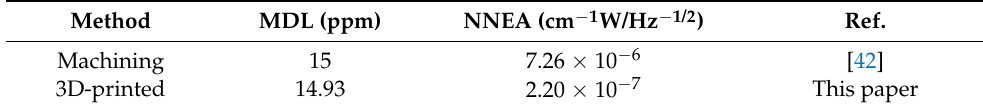
Table 1. The comparison between traditional machining and 3D-printed ADU.